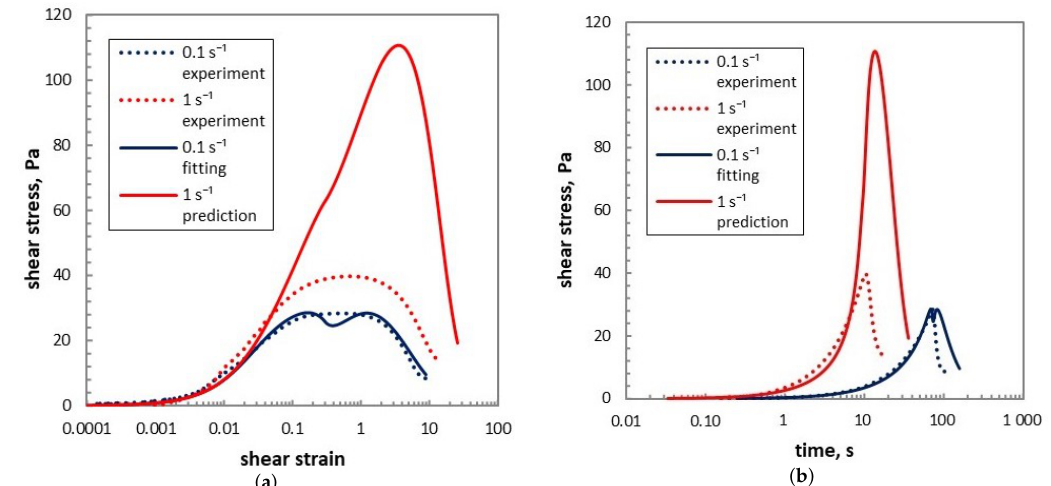
Figure 14. Predictions of shear stress as a function of shear strain and of time with Maxwell viscoelastic model for stress instead of Marrucci model Equation (17): ( a ) shear stress as a function of shear strain; ( b ) shear stress as a function of